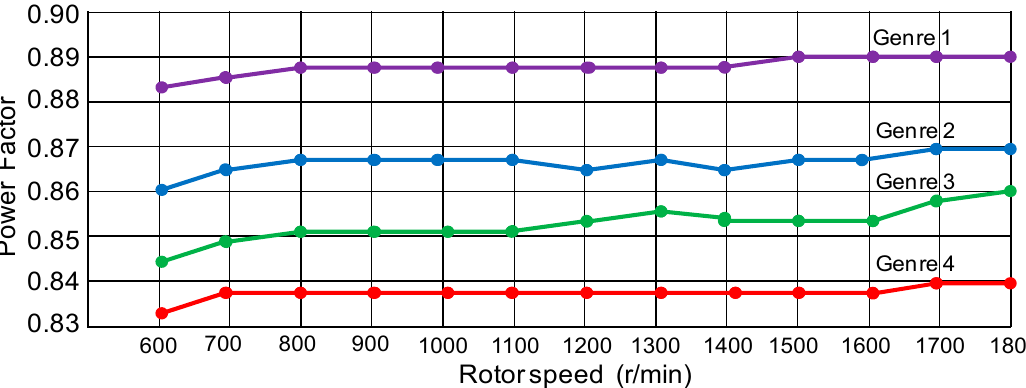
Figure 5. Line chart of comparisons of efficiency for 4 kinds of six-phase synchronous reluctance motors mounted to centrifugal compressor with various speeds.